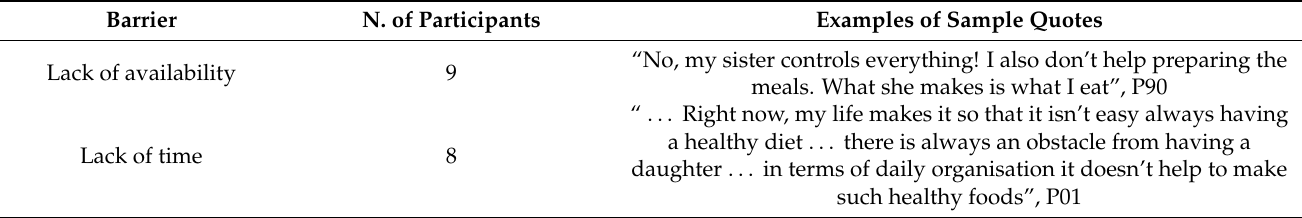
Table 4. Barriers in adopting a healthy